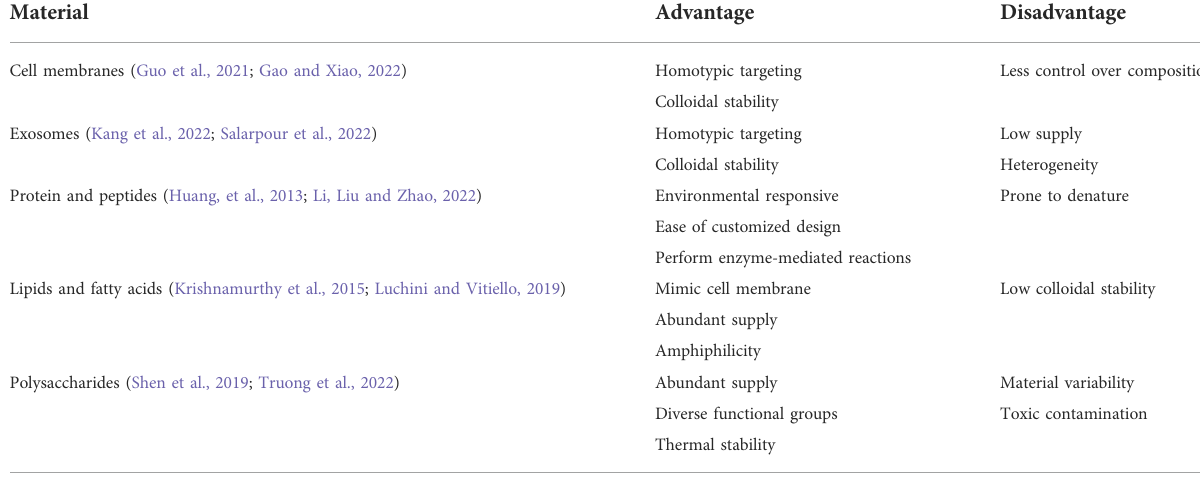
TABLE 1 Advantages and disadvantages of biological membranes and biomolecules of surface modi fi cation.